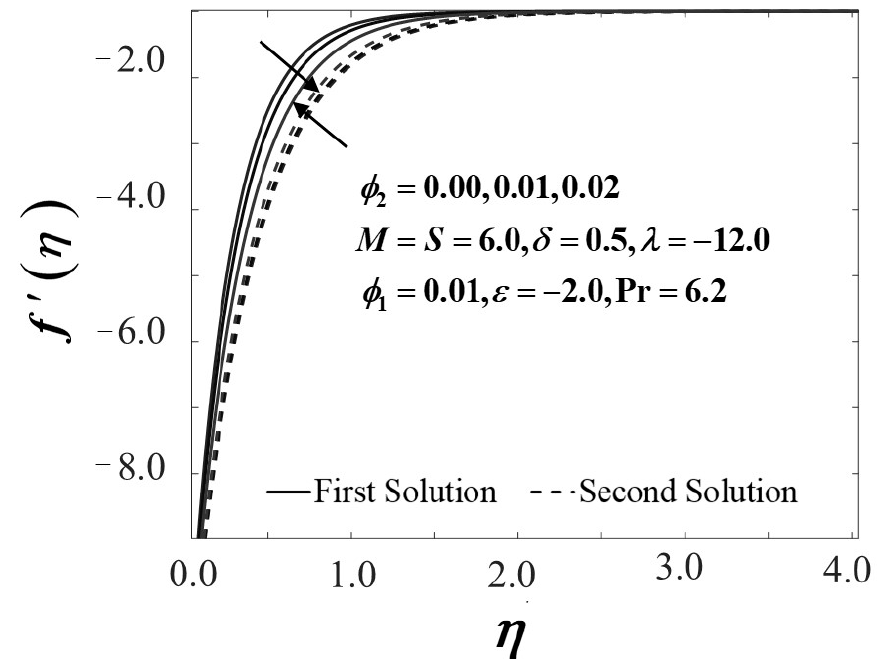
( ) f η ′ with various ( ) Figure 3. f (cid:48) ( η ) with various φ 2 when λ = − 12.0. Figure 3. f η ′ with various Figure 3.